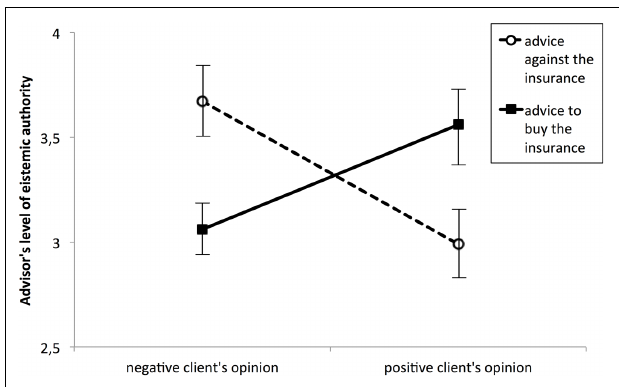
FIGURE 3 | Perceived epistemic authority of advisors as a function of their advice and client opinion on purchasing life